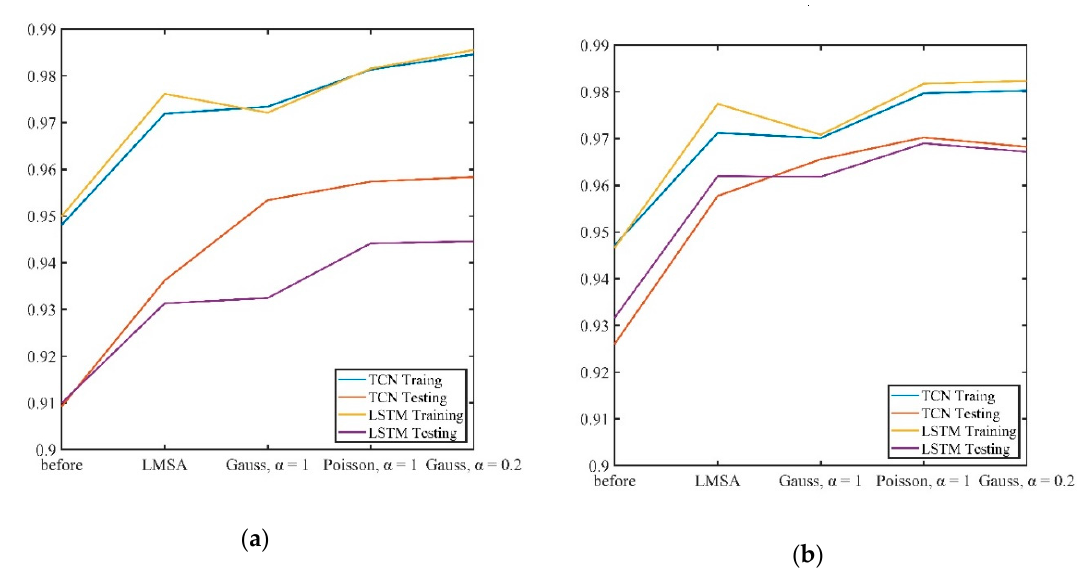
Figure 14. Comparison of results obtained before and after different state annotation methods. ( a ) PN-training-a. ( b ) LH-training.